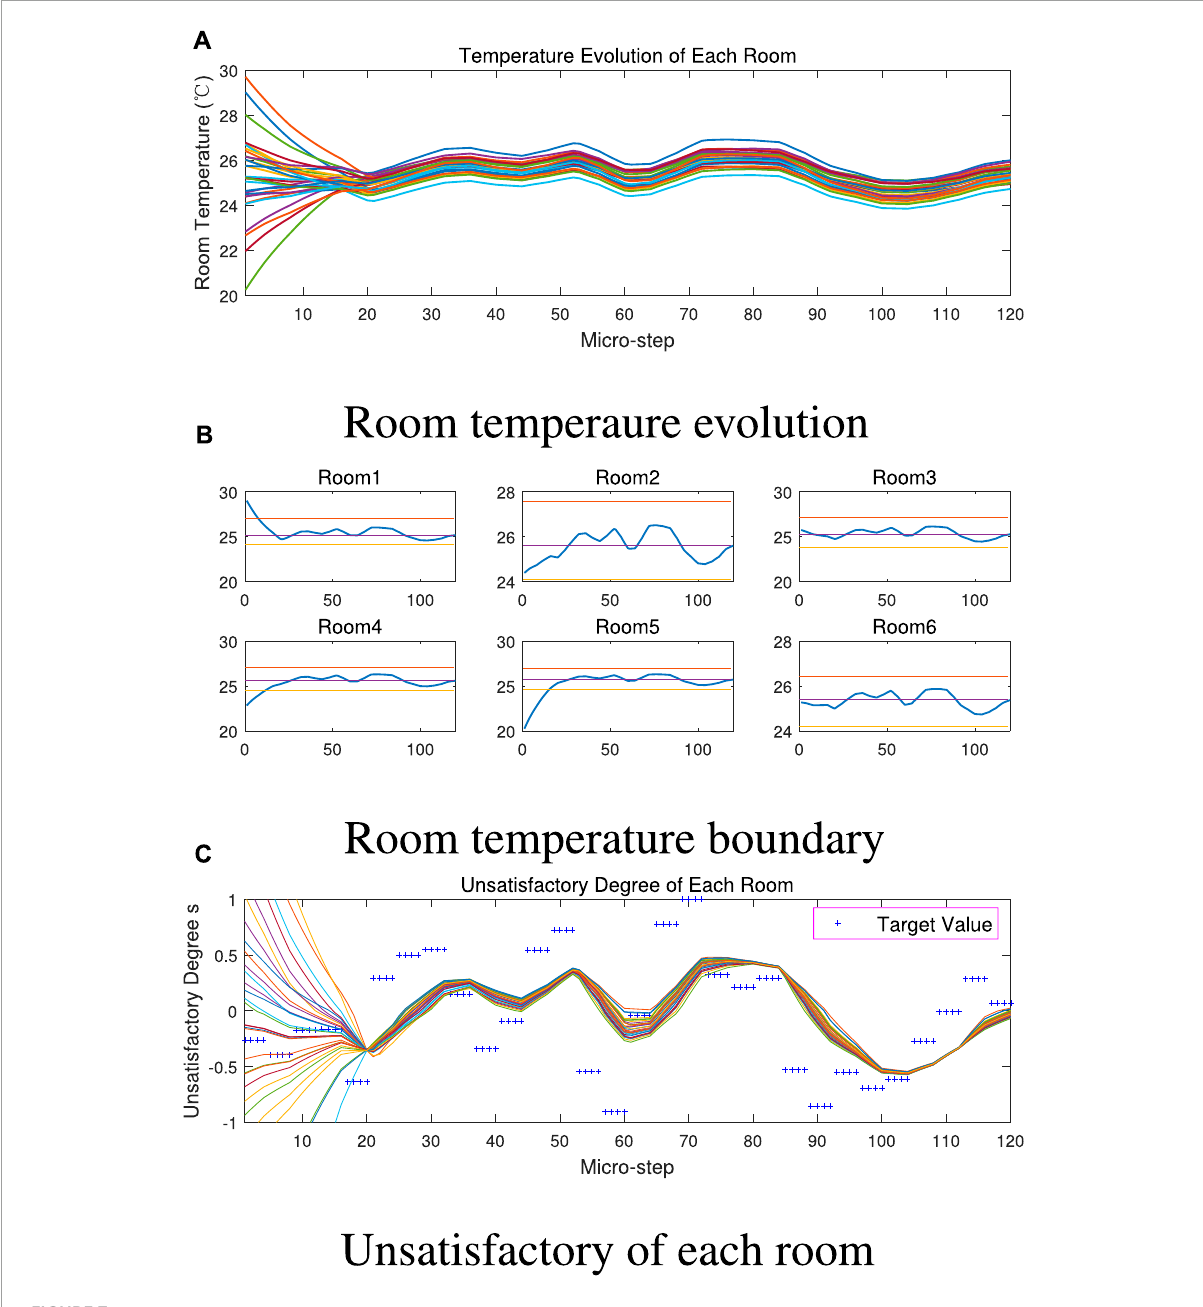
FIGURE 7 Evoluton of (A) , (B) room temperature and (C) unsatisfactory degree.